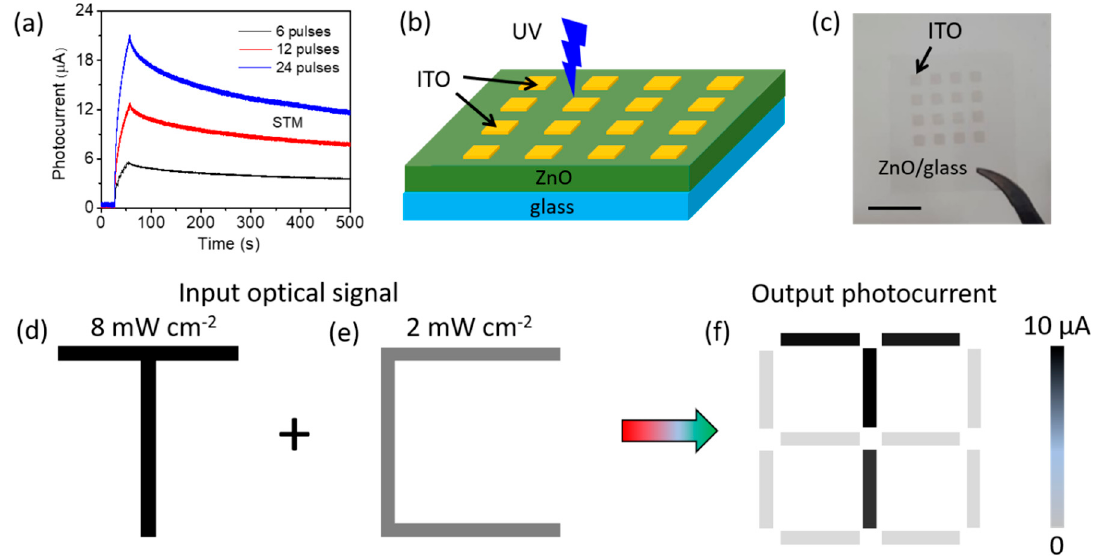
Figure 4. Mimicking neuromorphic spatiotemporal information processing. ( a ) Photoresponse of the ZnO ‐ based photodetector with different number of pulses. ( b ) An array of 16 devices, ( c ) original photograph of the devices. ( d ) Input UV intensity of 8 mW cm − 2 , ( e ) input UV intensity of 2 mW cm − 2 . ( f ) Output of the photocurrent.